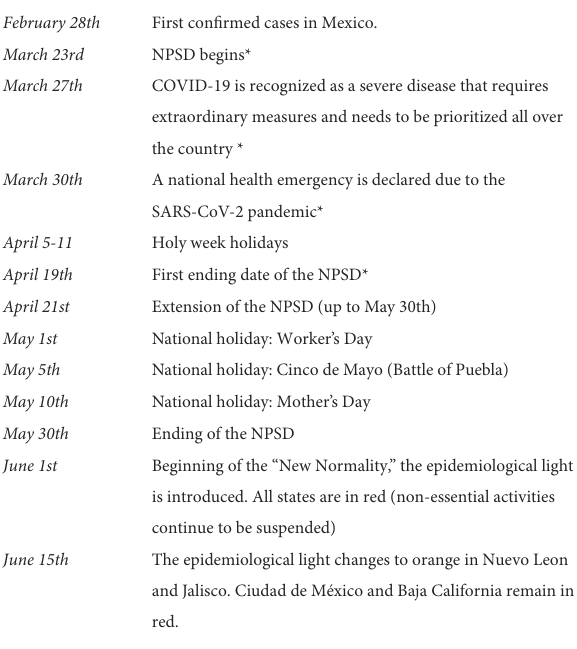
TABLE 1 Critical dates during the first months of the pandemic in Mexico (2020). Critical dates during the first months of the pandemic